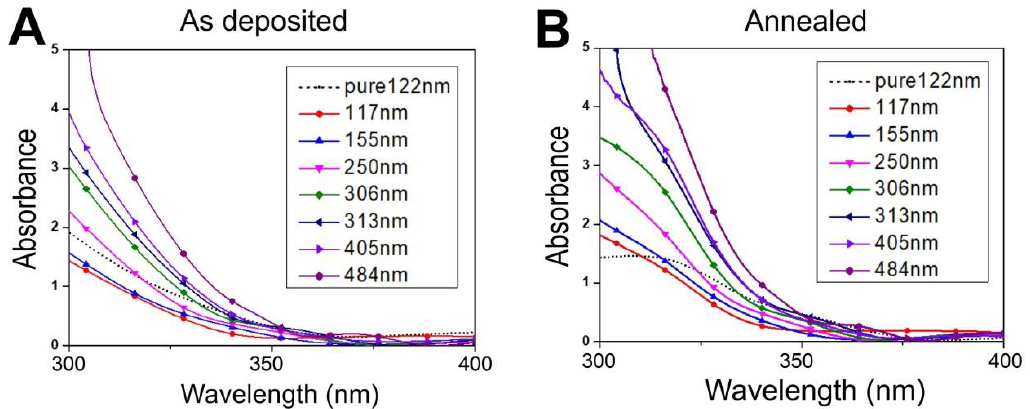
Figure 3. Ultraviolet (UV) – visible absorption spectroscopy analysis of TiO 2 (B) thin-film samples. The UV – visible absorption spectroscopy results of the TiO 2 (B) films, ranging from 117 nm to 484 nm, before ( A ) and after ( B ) annealing are showed.